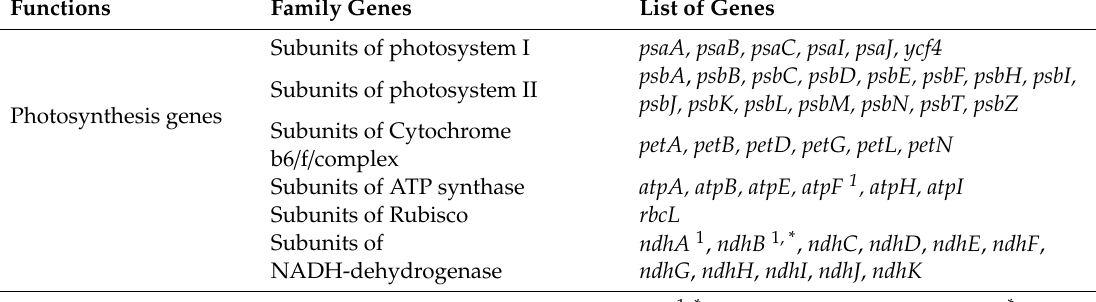
Table 1. Gene contents in the chloroplast genomes of Saccharum o ffi cinarum and S. spontaneum .